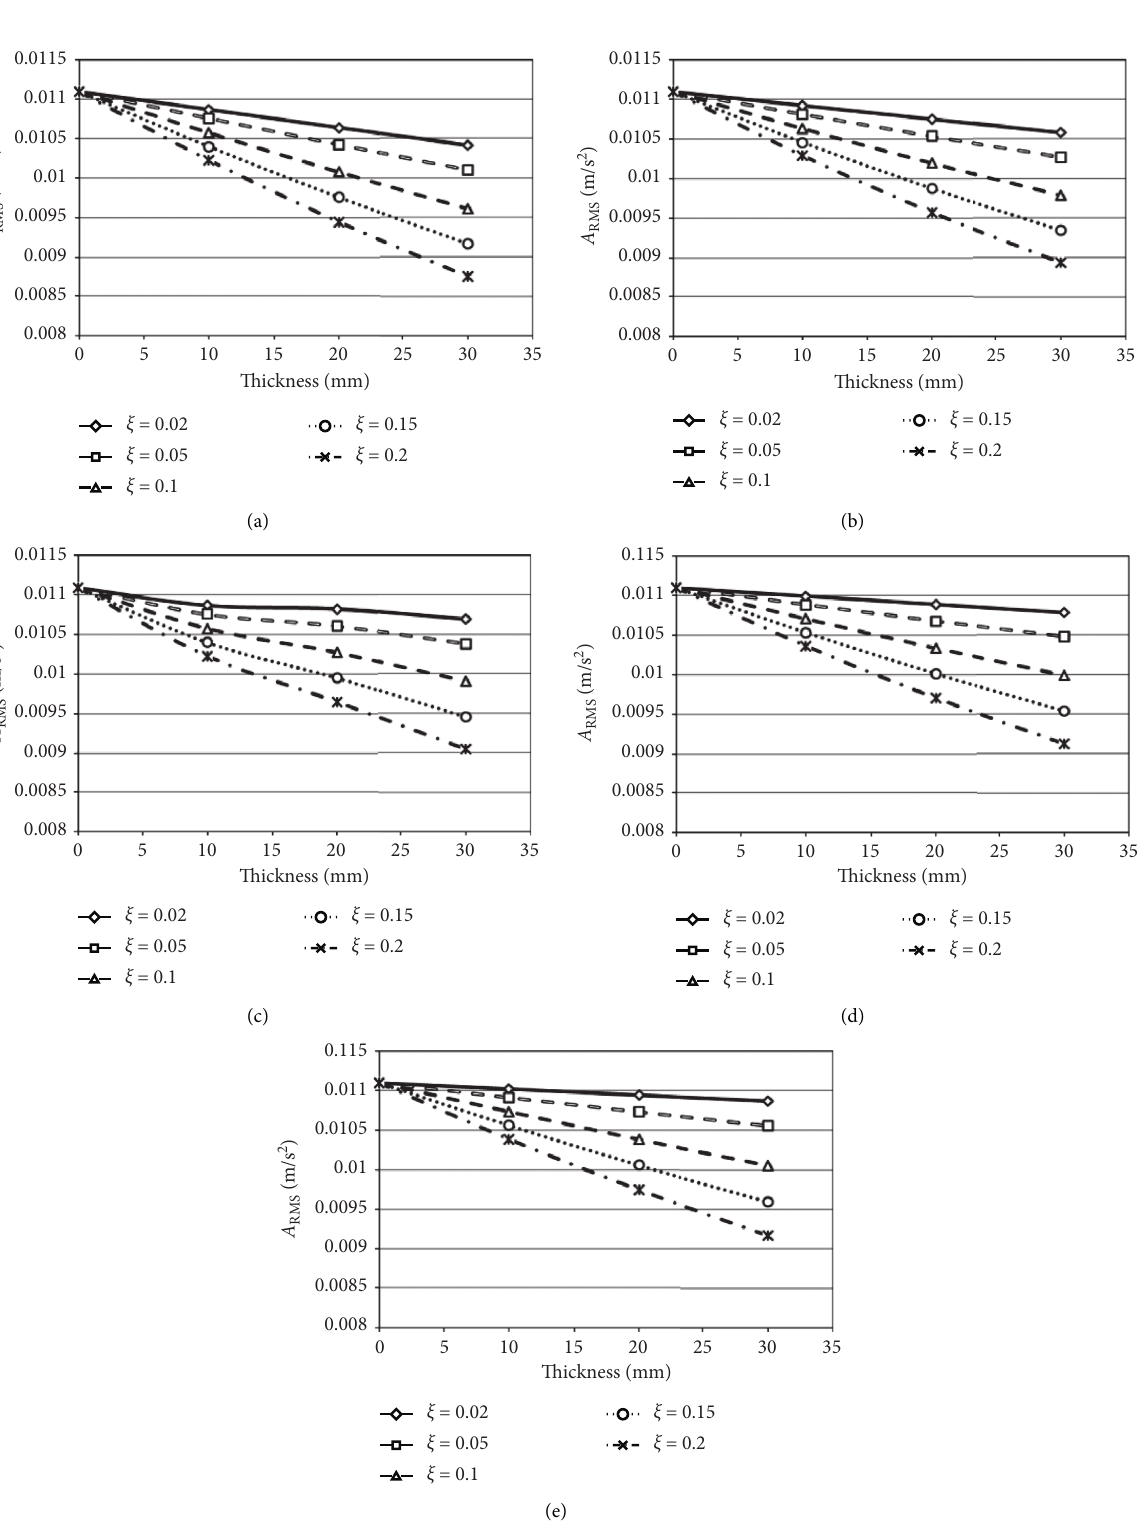
Figure 11: The effects of damping thickness at monitored point E (a) 0cm from the top. (b) 5 cm from the top. (c) 10cm from the top. (d) 15cm from the top. (e) 20cm from the